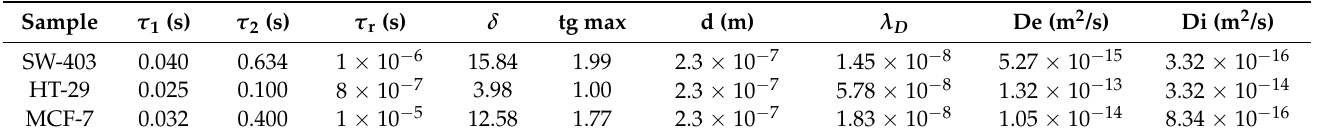
Table 2. Calculated parameters found by fitting the experimentally measured